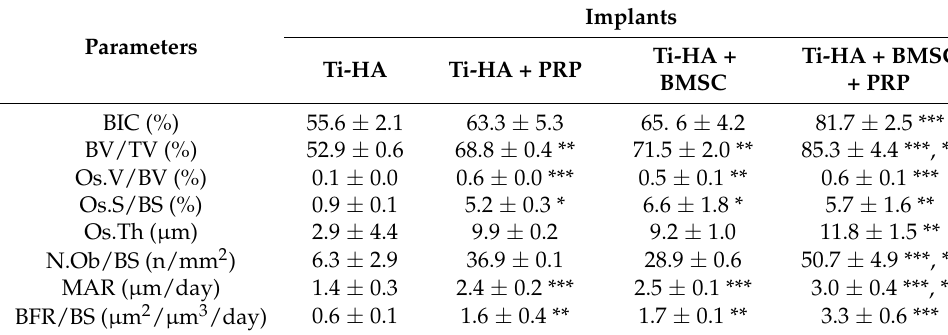
Table 3. Histomorphometric data 4 weeks after surgery (median ±